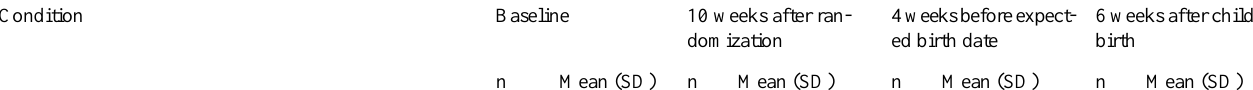
Table 2. Mean scores (standard deviations) for affective symptoms (primary and secondary outcomes) considering the intervention group and the control group at baseline, 10 weeks after randomization, 4 weeks before expected birth date, and 6 weeks after child birth.